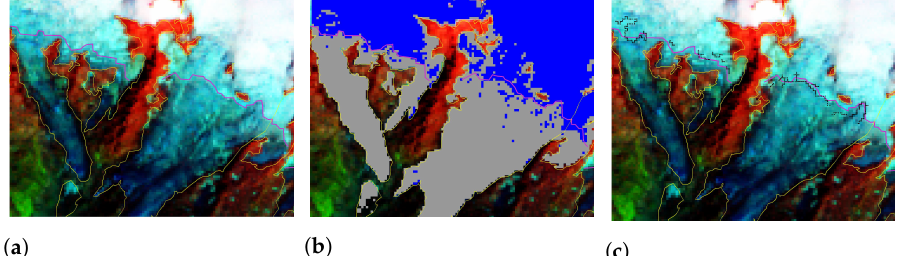
Figure 8. Illustration of a snow line detection over the Lys Glacier, southern side of Mont Rose (3 September 2019). The snow line is in purple. ( a ) Green/NIR/SWIR combination of the study area. ( b ) Classification of snow (in blue) and ice (in grey) with an SVM (linear kernel). ( c ) Resulting gradient computing.